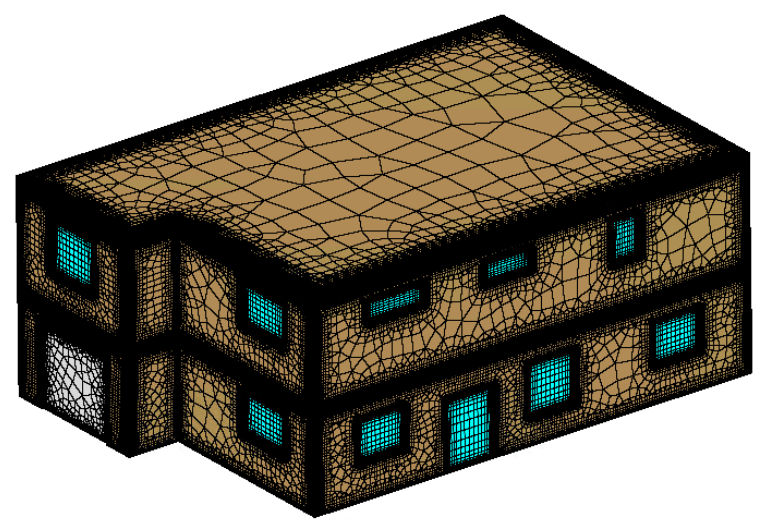
Figure 8. Residential house CFD mesh.